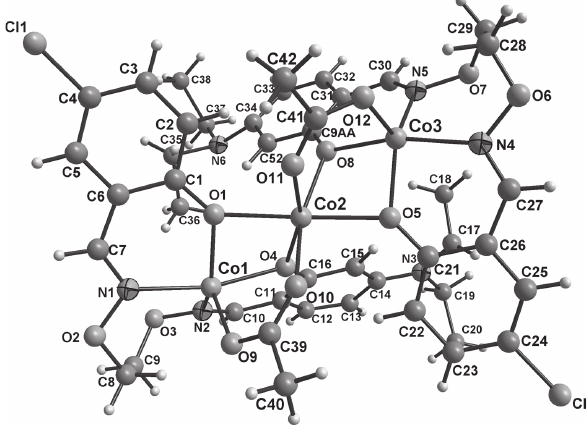
Table 1: Data collection and